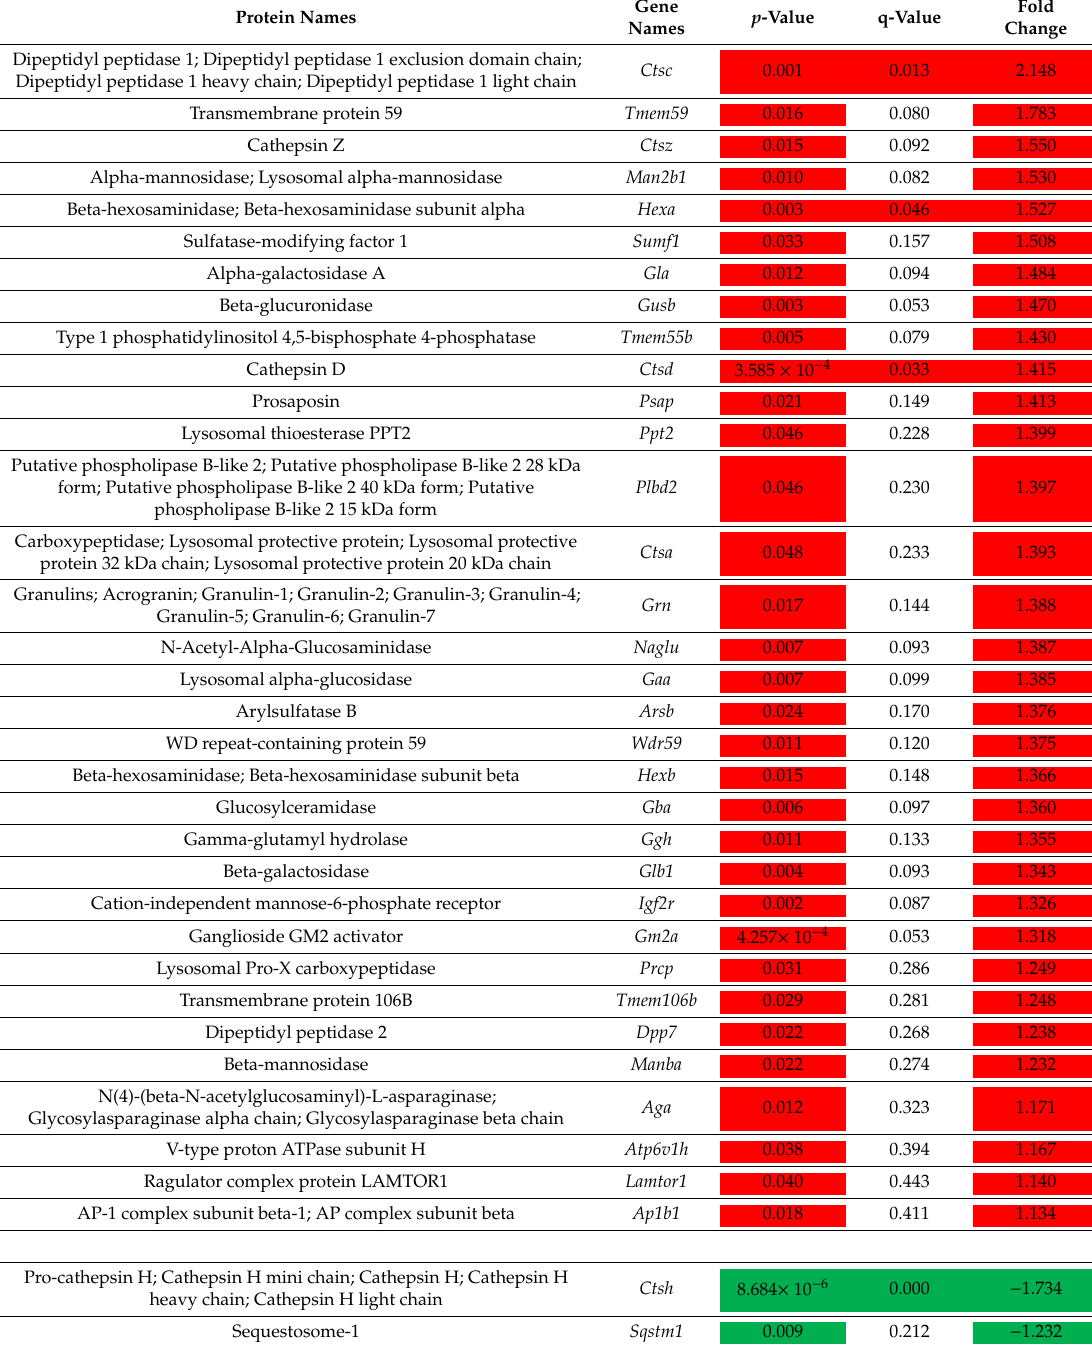
Table 4. List of dysregulated factors in the lysosomal compartment, ordered by direction of change (red for upregulations, dark green for downregulations) and by fold-changes. Gene Protein Names